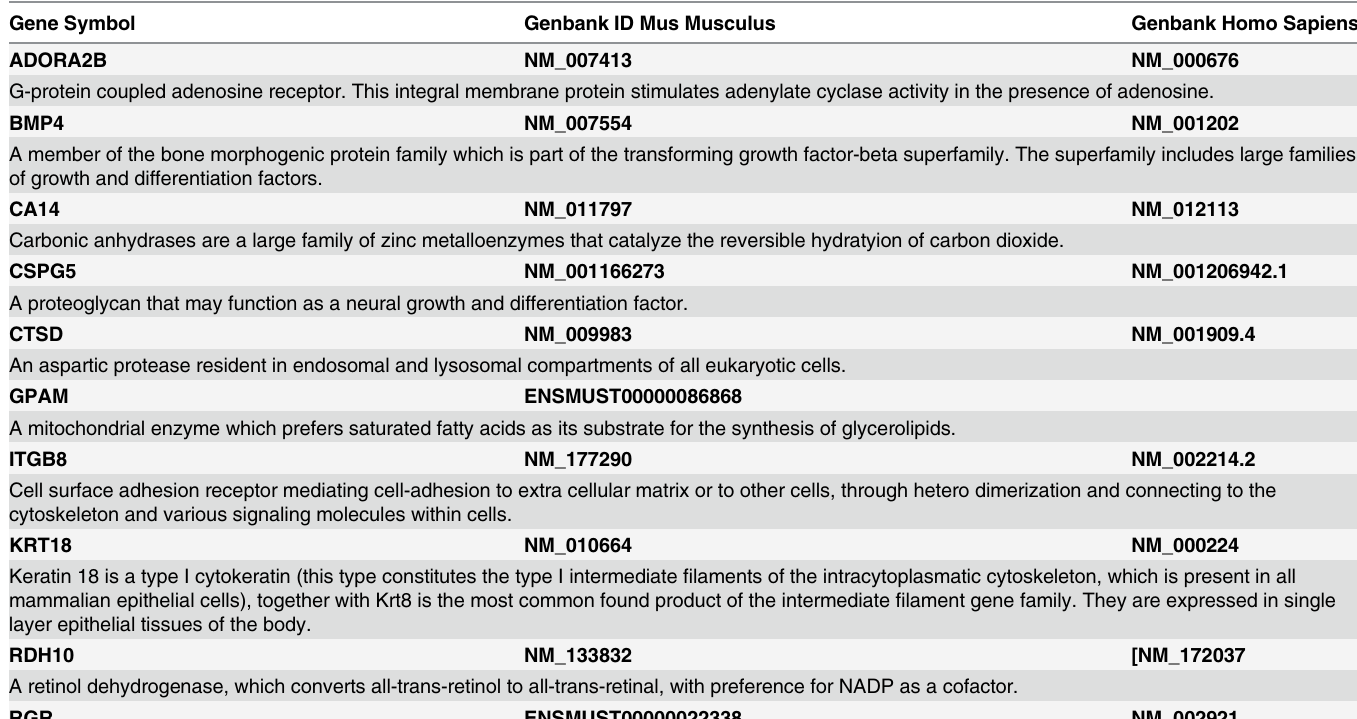
Table 2. The 22 signature genes that are specifically expressed in both RPE in mouse and in